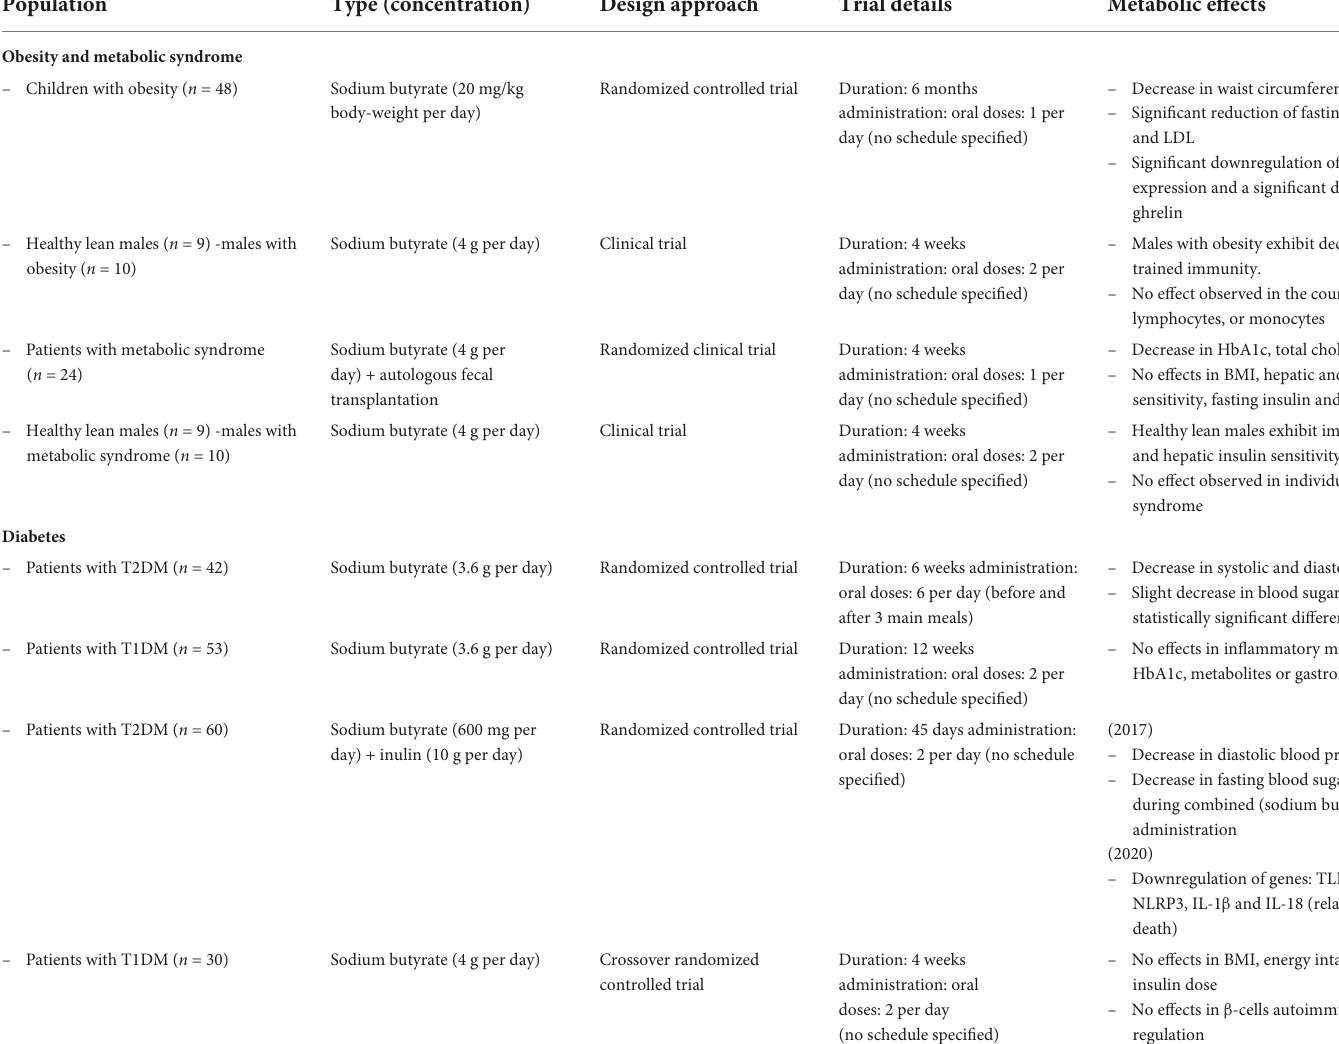
TABLE 1 Therapeutic interventions with butyrate